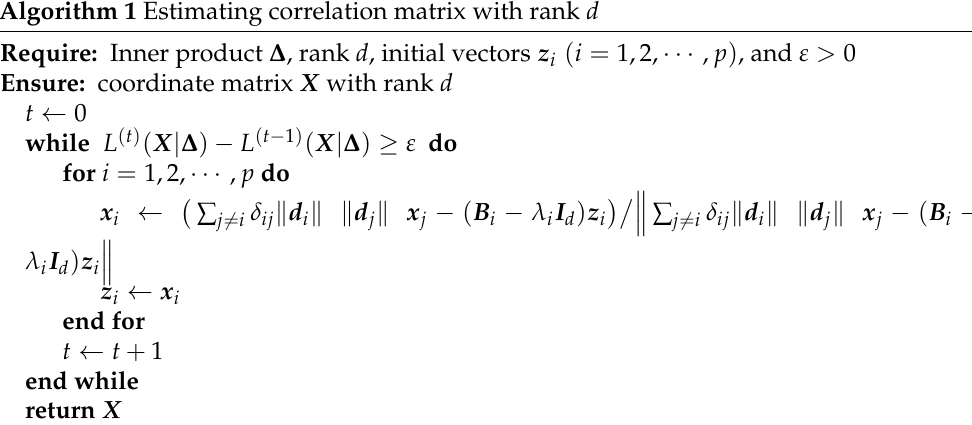
Algorithm 1 Estimating correlation matrix with rank